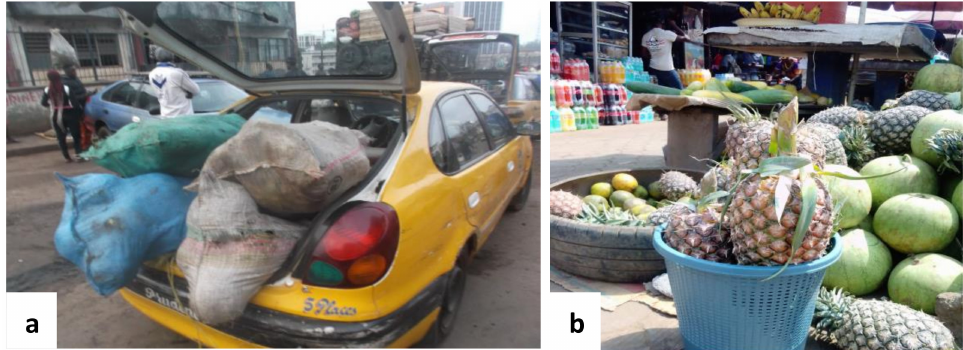
Figure 8. ( a ) Retailers transport watermelons in Yaound é , ( b ) Retailers sell pineapples inside perfo- rated plastic buckets in Yaound é , Cameroon, 2020. Photo by Aristide Kamda. “Narrative prevention project” (www.noodlesonlus.org) © courtesy of